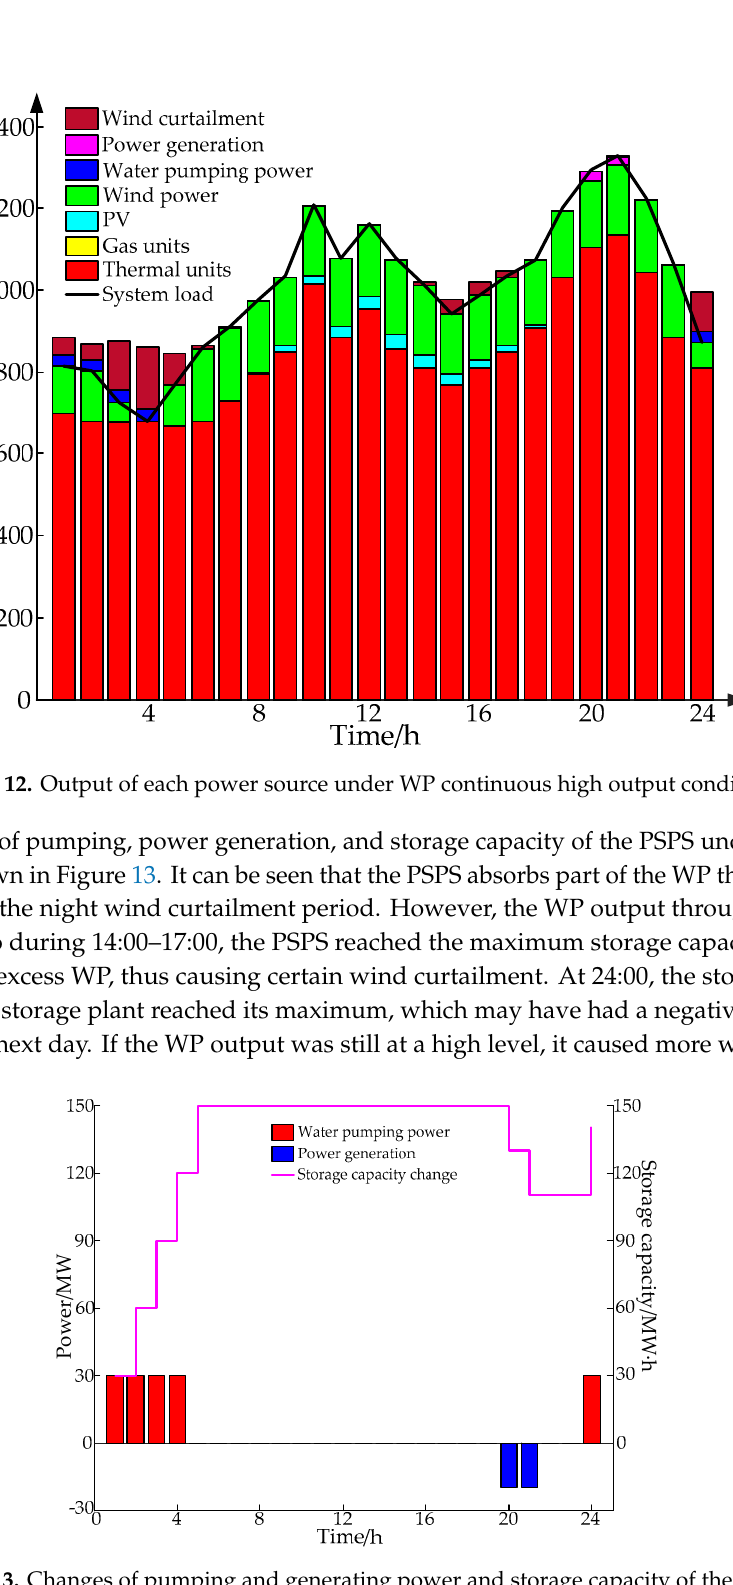
( b ) Figure 14. Comparison of reserve demand and supply under different schemes: ( a ) Up-regulated reserve comparison; ( b ) Down-regulated reserve comparison. 6.3.3. The Working Conditions with Continuous Small Wind Power Output The output of each power source under the third working condition is shown in Figure 15. In this working condition, the all-day output of WP was at a low level, which brought great pressure to the generation scheduling of thermal power units. At night, WP output was low and the thermal power units increased output to balance the load demand. During the daytime, during the two peak load periods and thermal power units were at a high output level. In order to ensure the reserve capacity, the pumped storage unit and gas power units participated in the dispatching. The pumped storage unit reduced the load level and the gas power units provided reserve capacity for the power system and increased the flexibility of the power system. WP was fully consumed by the coordinated dispatching of power generation and reserve capacity without affecting the reliability of the power system.